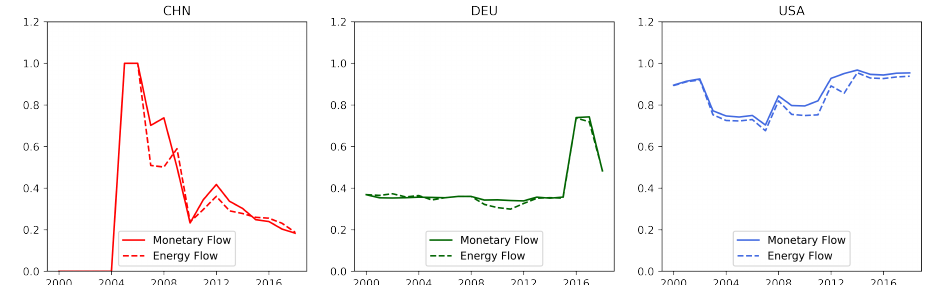
Figure 14. The evolution of individual country HHI for natural